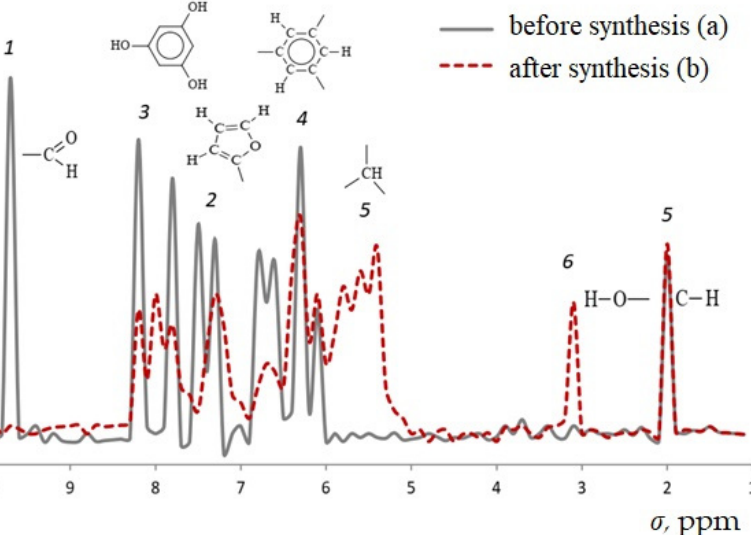
with the gradual introduction of a condensing agent, 1,3,5-trioxybenzene reacted in an